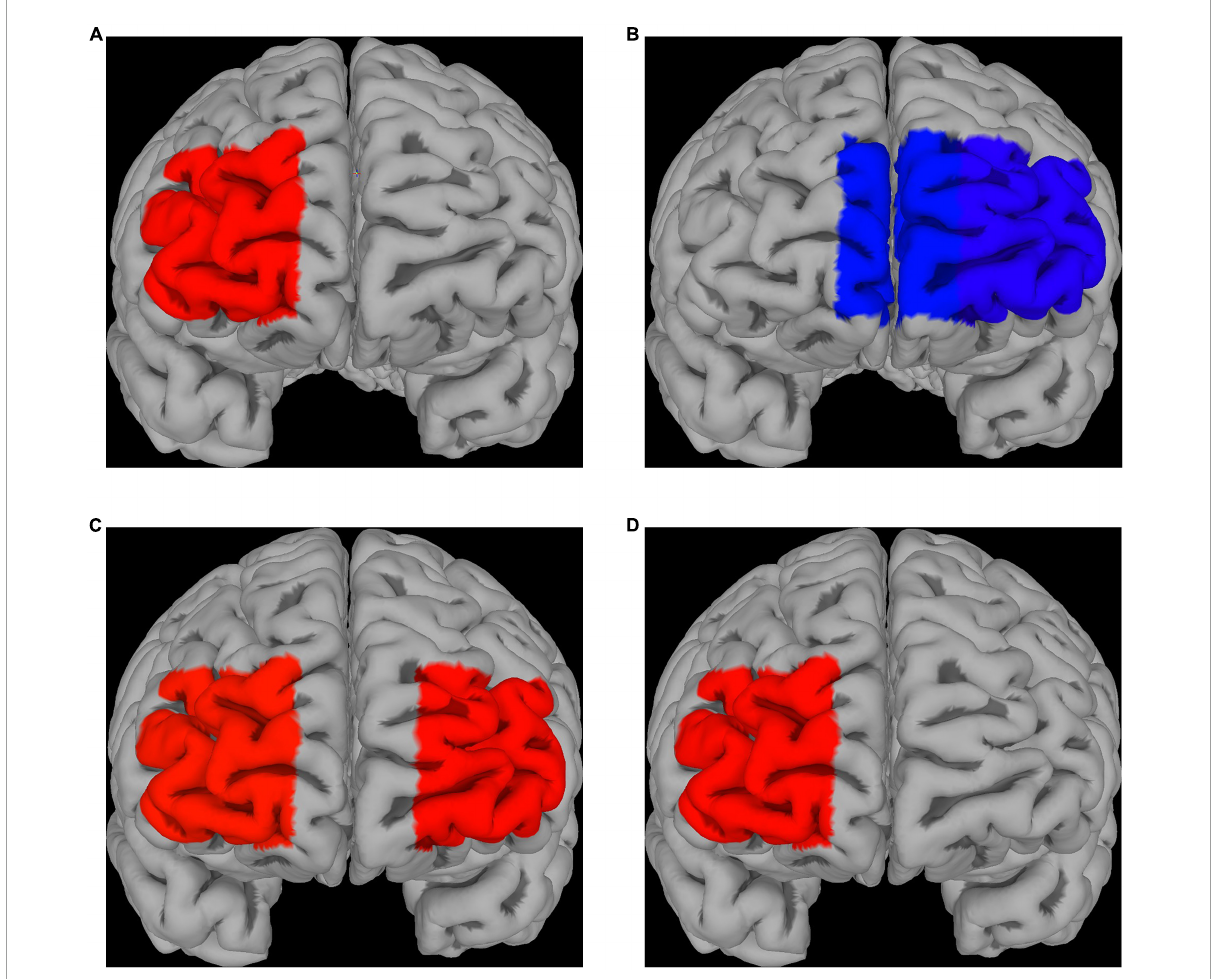
FIGURE3 fNIRS recordings. Differences in (cid:49) oxy-Hb levels during emotion induction (EI) [EI – REST] for fear (A) and disgust (B) ; significantly greater activations compared to the control phase were seen in right PFC for fear after escitalopram was administered, whereas significantly less activation in medial and lateral PFC was seen in disgust. (C) Differences in (cid:49) oxy-Hb levels during EI [EI – REST] when comparing the two emotions after escitalopram administration show greater activation of lateral PFC in fear compared to disgust. (D) Direct contrast psychological emotion regulation (reappraisal) [ER contrast in control] with pharmacological emotion regulation (escitalopram) [EI contrast in Intervention phase, escitalopram] in fear demonstrated greater activation for the latter in right PFC, with no PFC areas found to be significantly more activated by reappraisal compared to escitalopram. No significant differences were found for